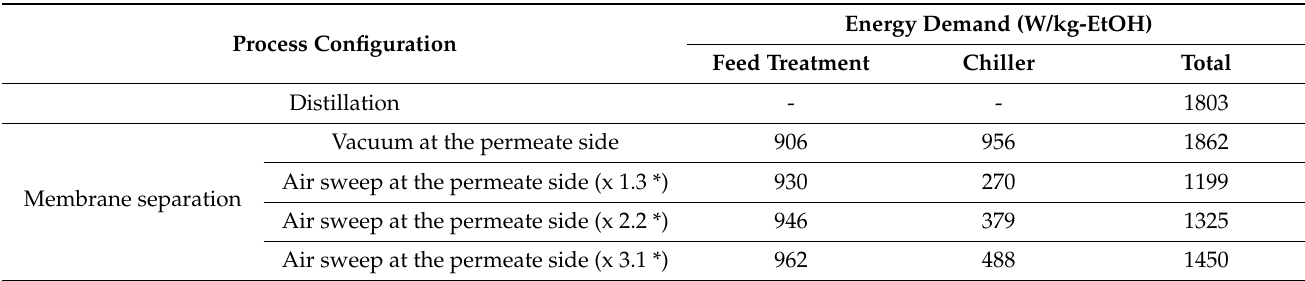
Membrane separation